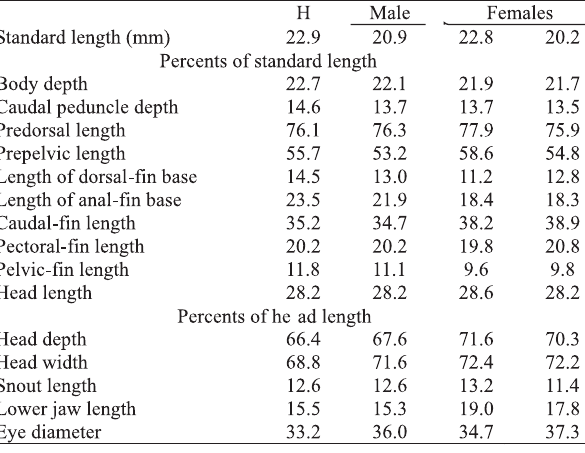
Fig. 9. Rivulus rutilicaudus , UFRJ 5966, female, paratype, 22.8 mm SL (one day after collection); Brazil: Goiás: